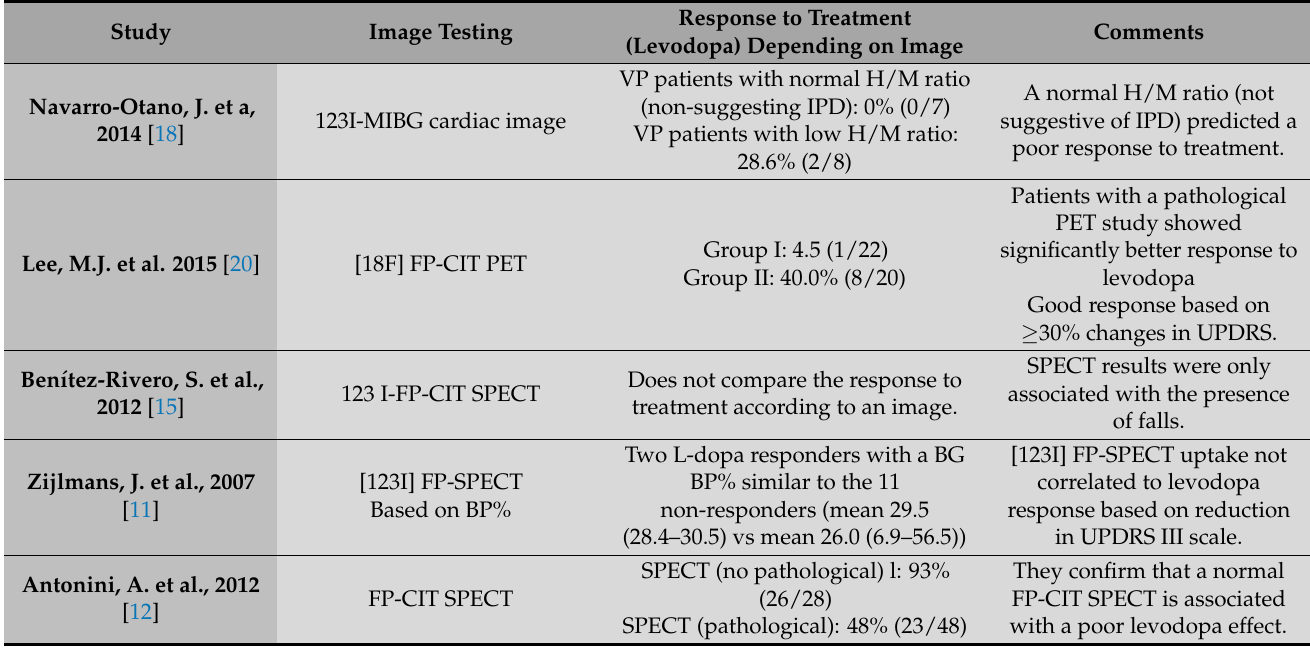
Table 3. Studies results based on imaging techniques.